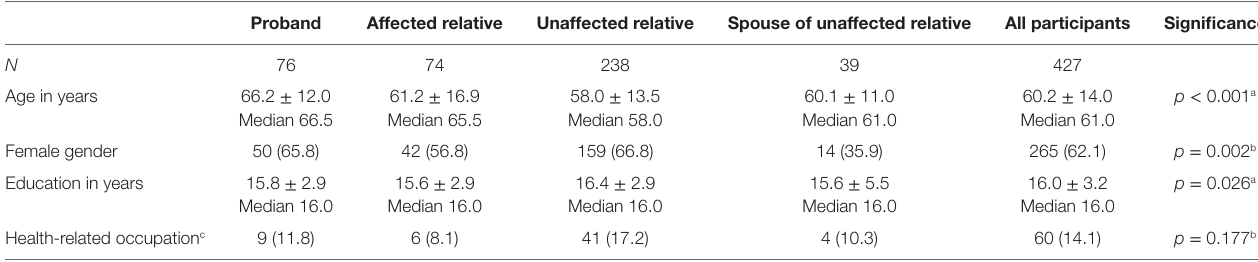
TaBle 1 | Demographic characteristics of 427